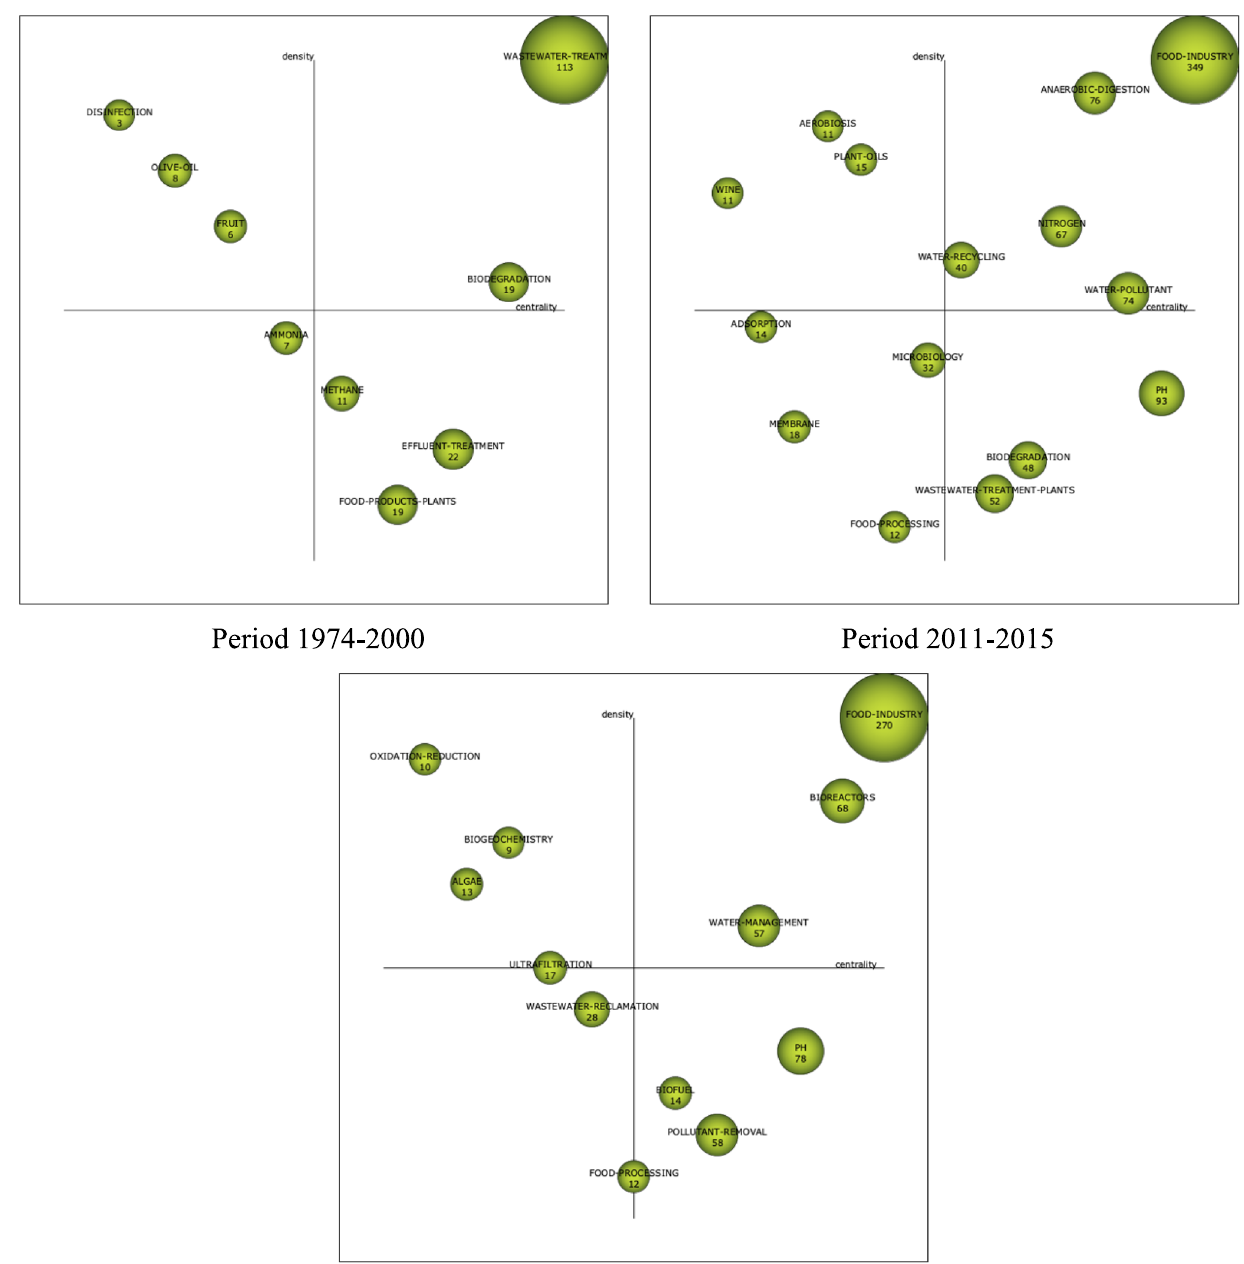
Fig. 9 Strategy diagrams in terms of number of documents